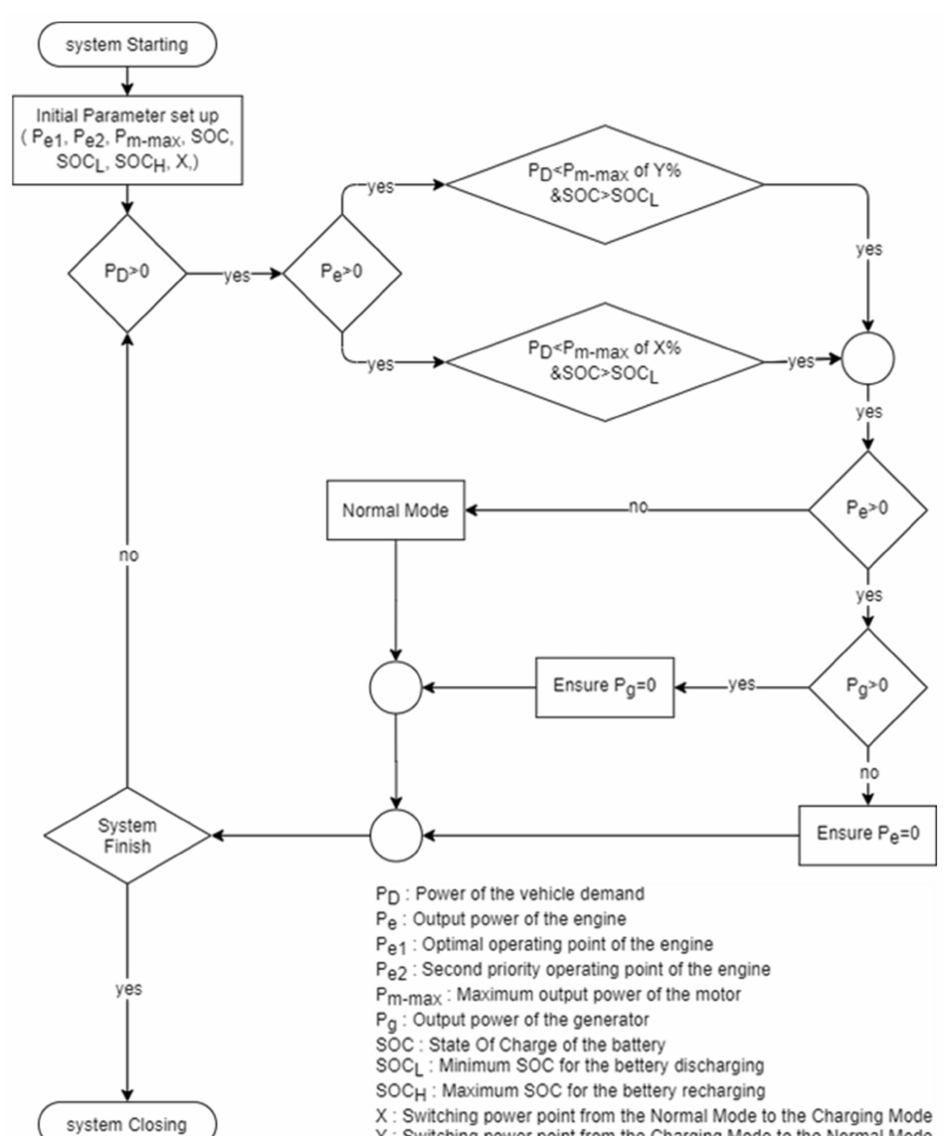
Figure 2. Flowchart of the motor output control